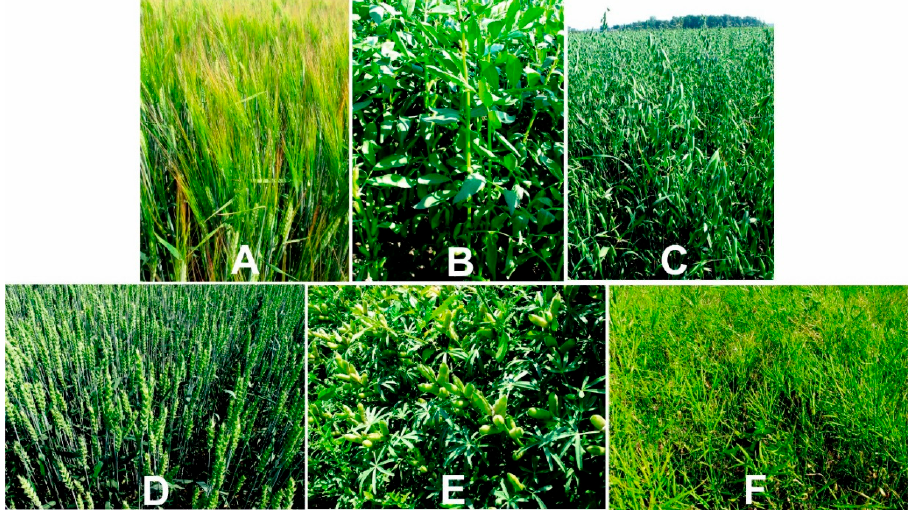
Figure 1. Crop species: ( A ) barley, ( B ) faba bean, ( C ) oat, ( D ) wheat, ( E ) lupin, and ( F ) turnip rape.